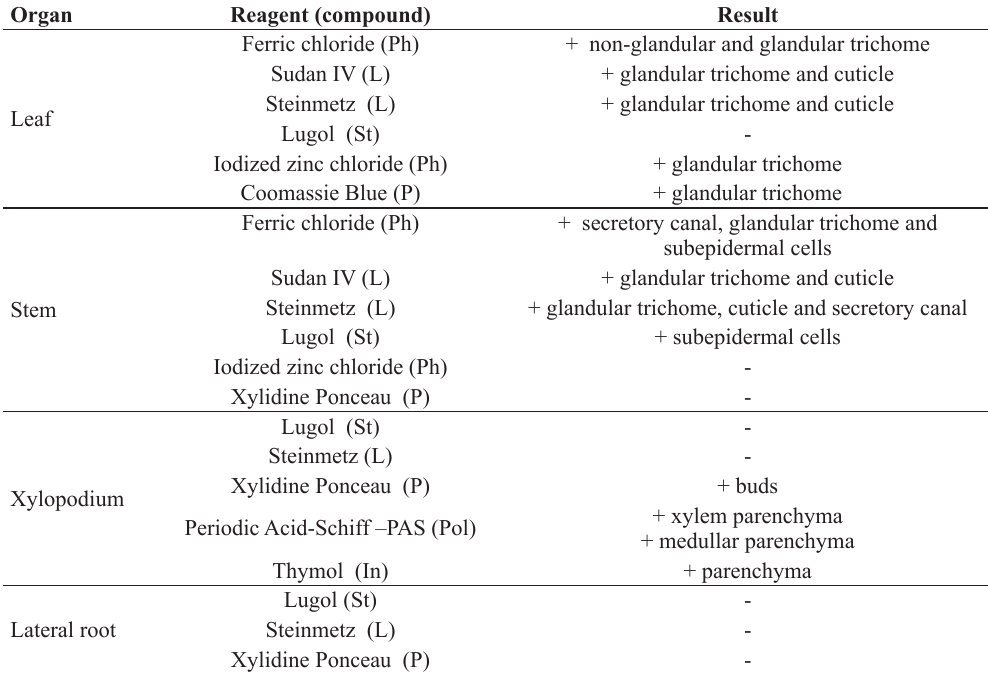
Distribution of metabolites on different aerial and underground organs of Dimerostemma vestitum detected by histochemical